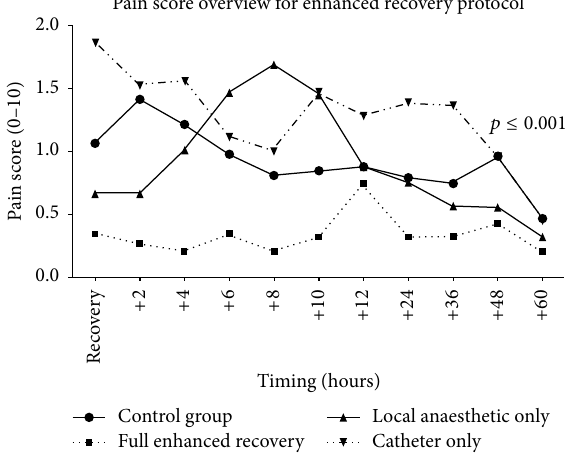
Figure 1: Numerical Reporting Scale (NRS) pain scores for the control group and the enhanced recovery